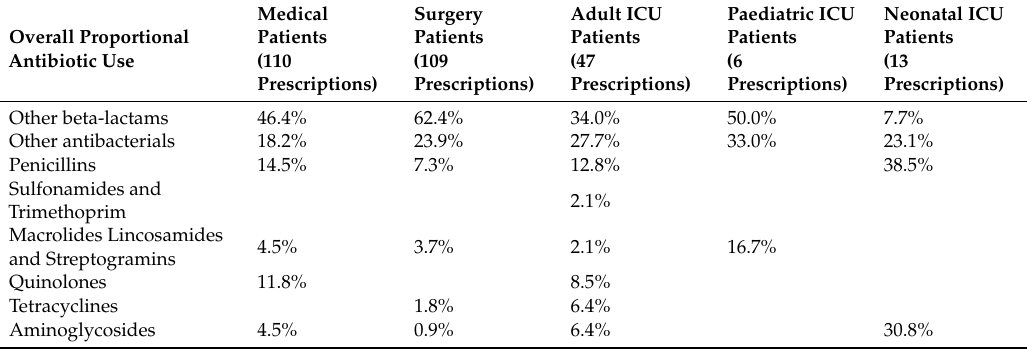
Table 2. Overall proportional antibiotic use (ATC J01) for medical, surgery, adult ICU, paediatric ICU, and neonatal ICU